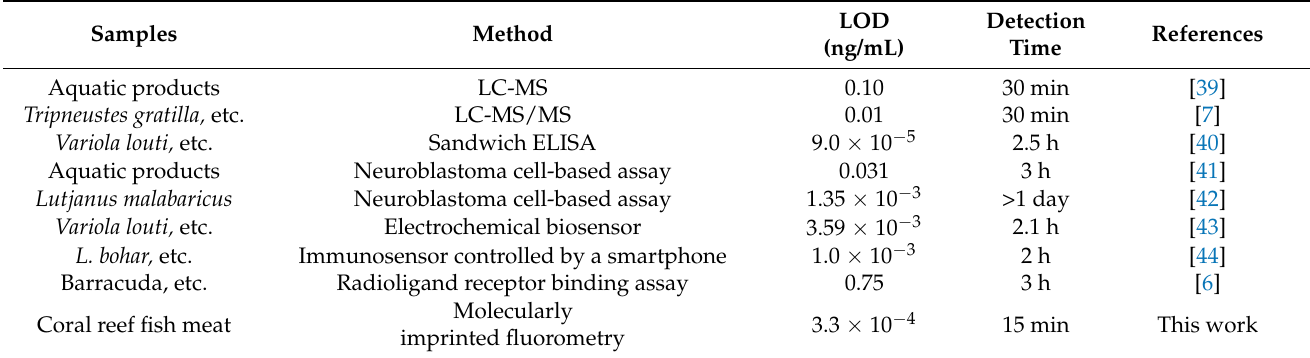
Table 2. Comparison of representative analytical methods for P-CTX-3C